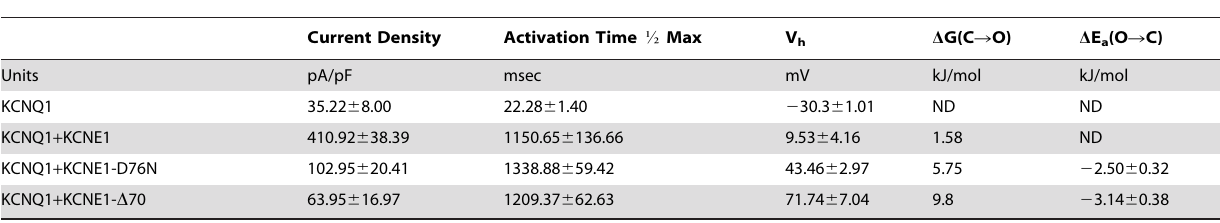
N=6. Abbreviations: V h voltage at which half the channels are activated; D G(C R O) change in Gibbs free energy for the closed and open states during channel activation; D E a (O R C) change in activation energy for the transition from open to closed states relative to wild-type KCNE1. (ND, not done).